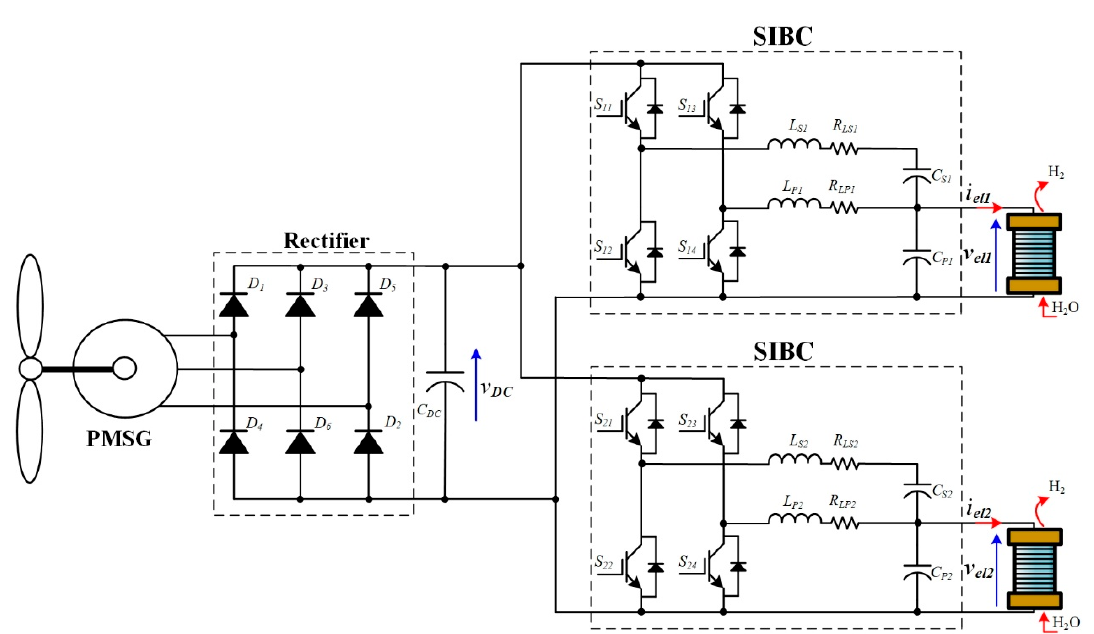
Figure 19. Multi-stack electrolyzer based on parallel configuration.